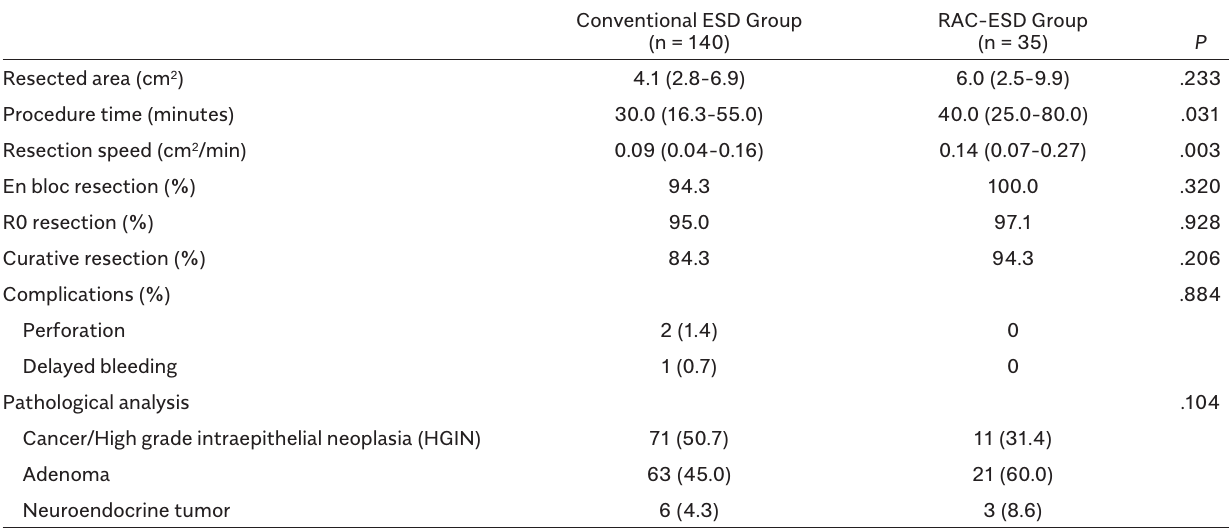
Table 3. Outcomes of the Patients with Superficial Colorectal Neoplasms Treated by Endoscopic Submucosal Dissection Using Rubber Band and Clip (RAC-ESD) and Conventional ESD in the Matched Cohort